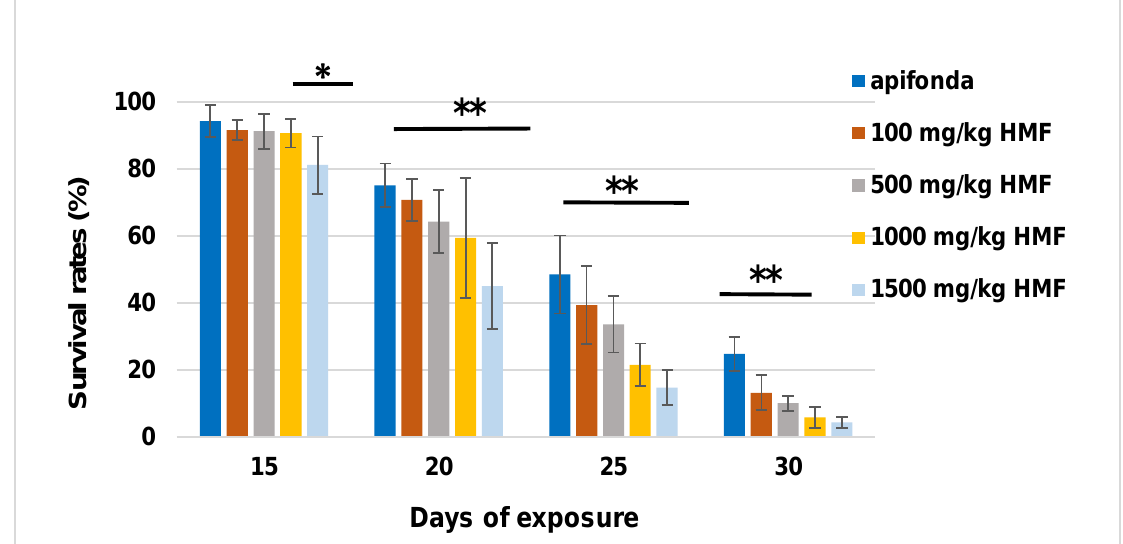
Figure 2. The relative number of live caged bees on the 15th, 20th, 25th, and 30th day of the experiment. The figure shows dates with the highest differences of survived bees between treatment groups. Asterisks indicate statistically significant differences between treatment groups. The Tukey test shows a difference at p < 0.05 (*) and at p < 0.01 (**).